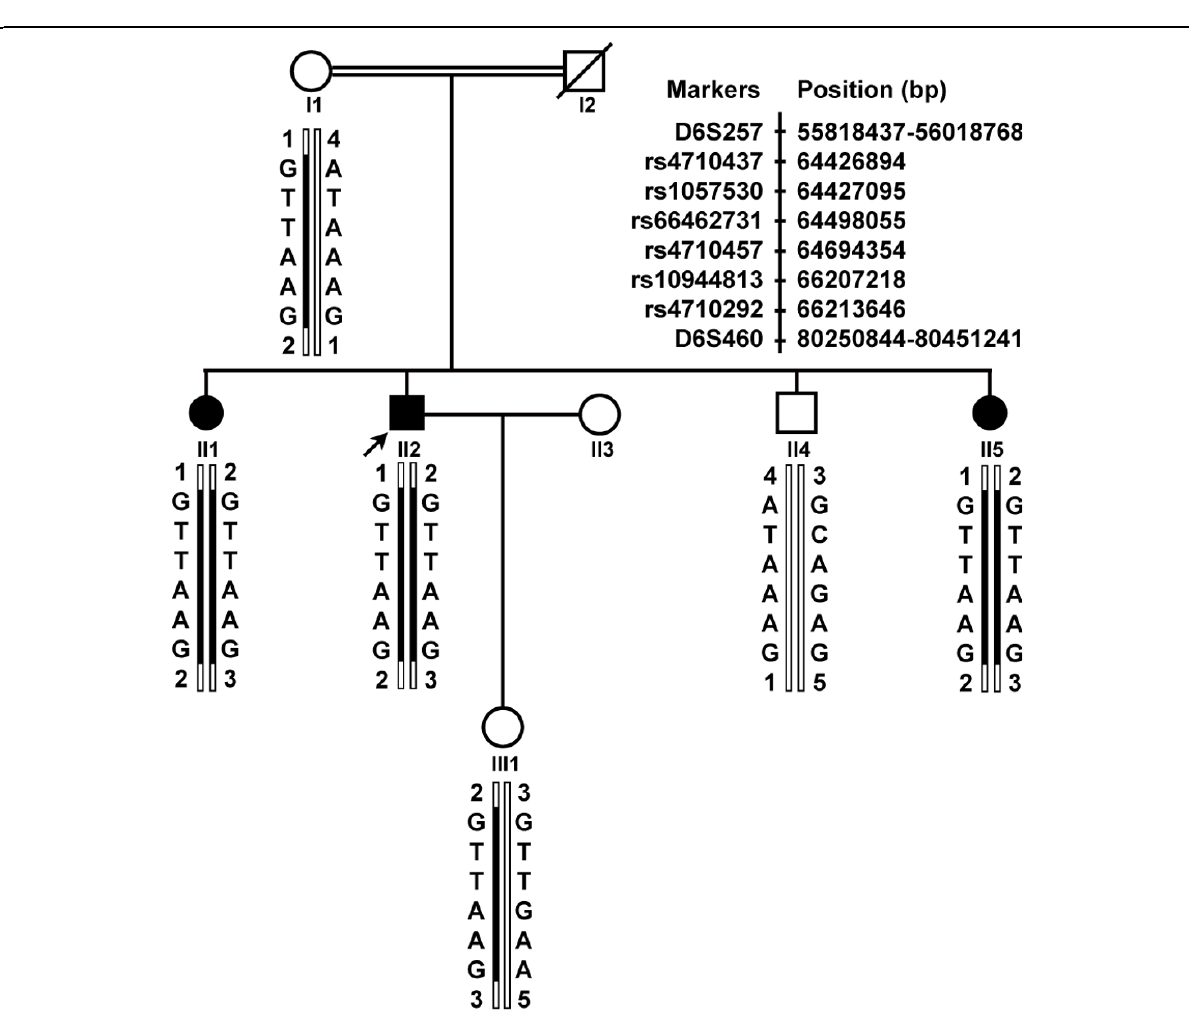
Figure 1 Pedigree structure and haplotype analysis at the RP25 locus . Blackened bars indicate the disease haplotype. Filled squares or filled circles represent male or female individuals affected with RP, respectively. Arrow points to the proband (II2). All patients in the arRP family carry the homozygous haplotype between single nucleotide polymorphisms rs4710292 and rs4710437. The genomic positions of two markers are from Human ( Homo sapiens ) Genome Browser Gateway, the GRCh37 build version, and six SNPs are from NCBI B37.1